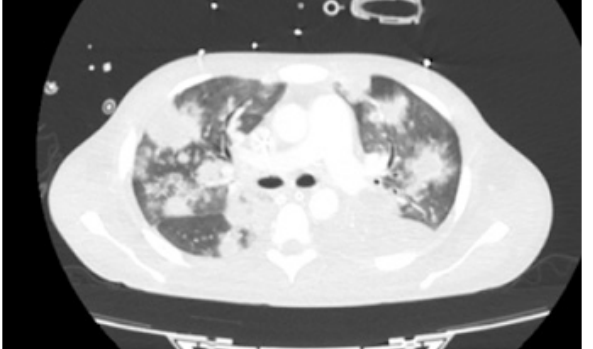
Figure 2. Thoracic CT scan on day +43 demonstrating multiple homogeneous nodular lesions scat- tered throughout the parenchyma